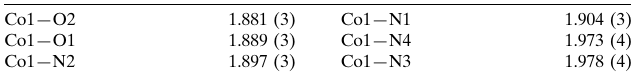
Selected bond lengths (A˚ ).